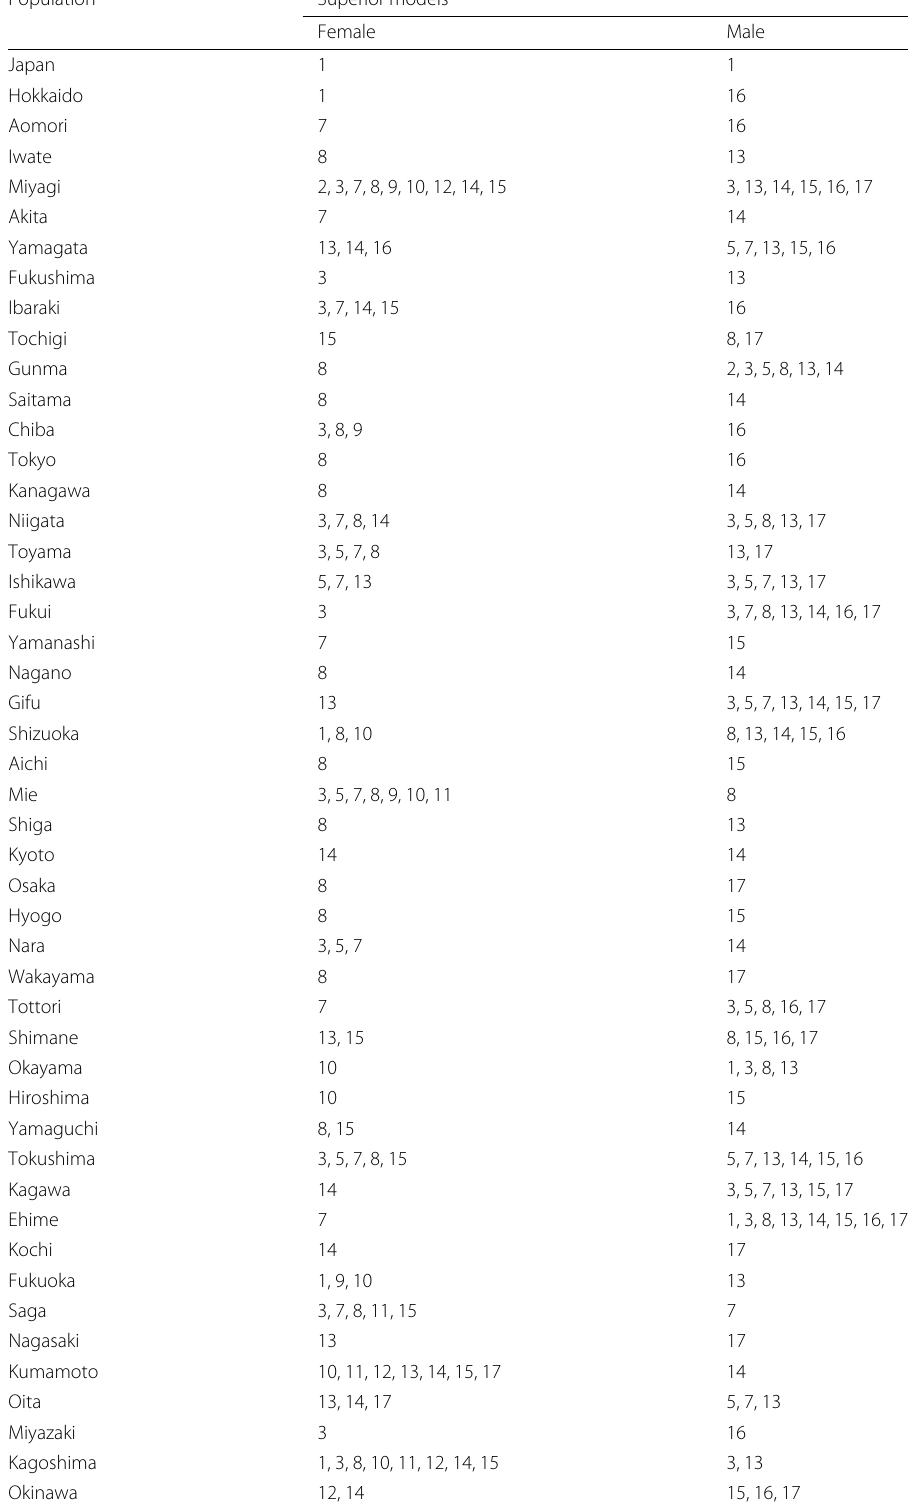
Table 3 MCS procedure using the T R,M test applied to the RMSFE in the validation set from 1996 to 2005 for forecasting the Japanese female and male national and sub-national mortality for ages between 60 and 100+ Population Superior models